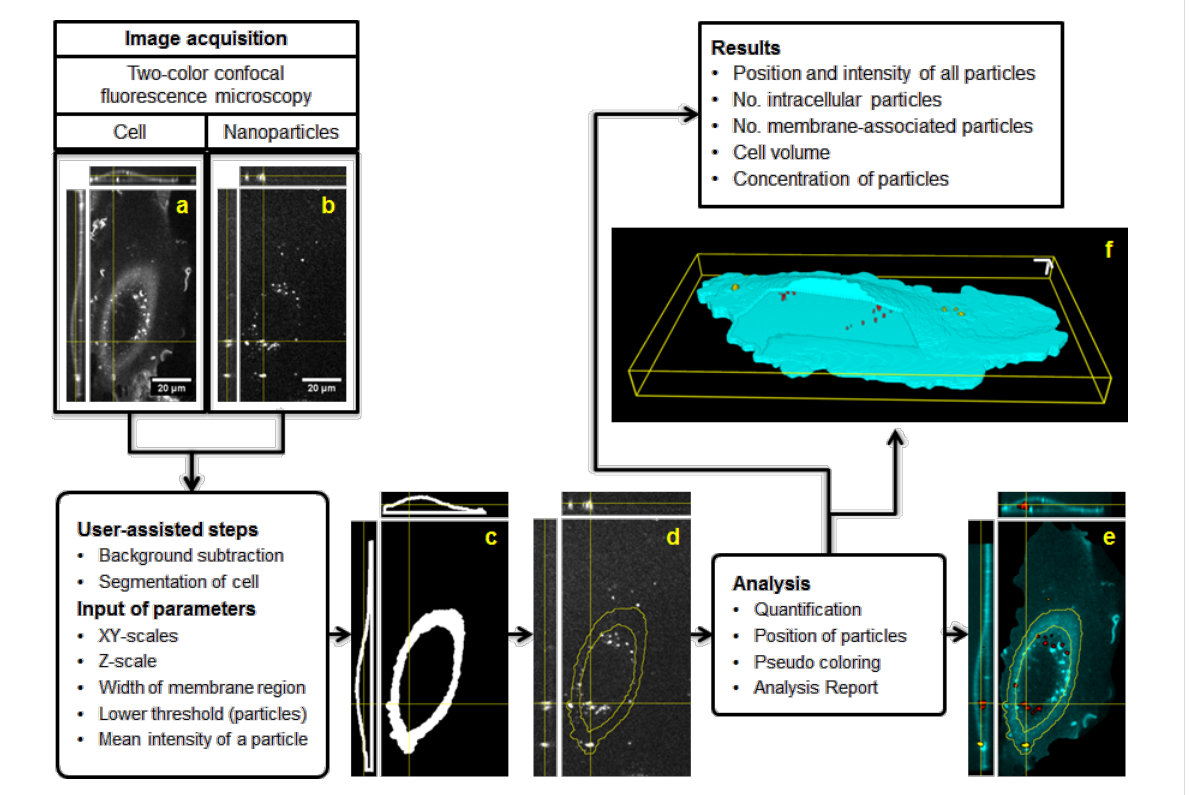
Figure 1: Particle_in_Cell-3D processing overview. (a) Representative confocal section image and orthogonal projections of a HUVEC cell membrane stained with CellMask™ Deep Red. (b) The respective image of silica nanoparticles labeled with perylene, a fluorescent dye. The 3D location of an intracellular particle is marked by the crossing yellow lines. (c) A smoothing filter is applied and the image of the cell is transformed into a white mask. The image stack of masks is further processed to deliver a 3D reconstruction of the cell boundaries. Intracellular and membrane region are also defined in this step. (d) The cell boundaries, or regions of interest, are then used to segment the image of the nanoparticles (yellow outline). The segmentation procedure occurs throughout the image stack, leading to a 3D localization of the particles with respect to the cell. (e) Quantitative image analysis takes place. The intensity of each object (particle or agglomerate) is compared to the intensity of a single particle previously measured in a calibration procedure. Nanoparticles are pseudo-colored according to the cellular region. In this example the cell membrane is shown in cyan, the intracellular nanoparticles appear in red, and the membrane-associated nanoparticles in yellow. (f) 3D representation of nanoparticle uptake after evaluation. Intracellular nanoparticles can be seen through the window intentionally open in the membrane region (cyan). 3D scale bars = 5